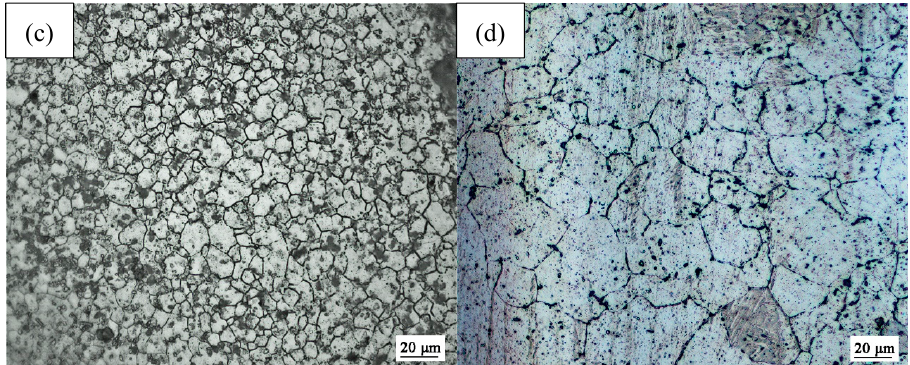
Figure 9. OM images of AZ80 + 0.4%Ce magnesium alloys after fourth pass extension with different temperatures: ( a ) 270 °C, ( b ) 310 °C, ( c ) 350 °C, ( d ) 390 °C. SEM images of magnesium alloy tubes after the